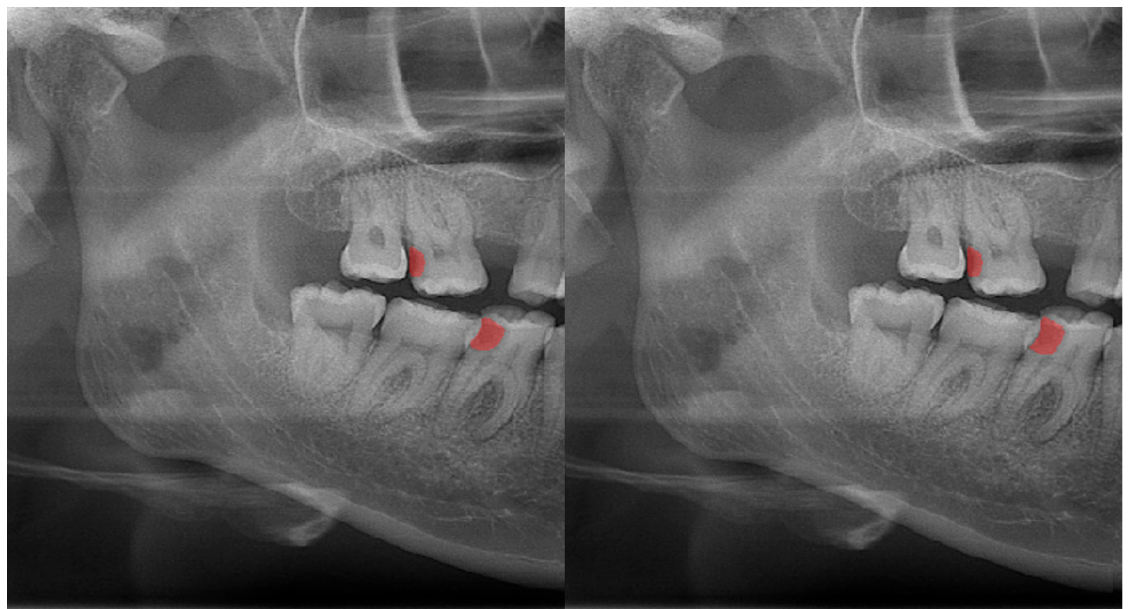
Figure 2. Automatic segmentation of the teeth. Manual segmentation ( upper image ) and automatic segmentation ( lower image ) can be seen above. Each tooth has a unique label according to FDI World Dental Federation notation.